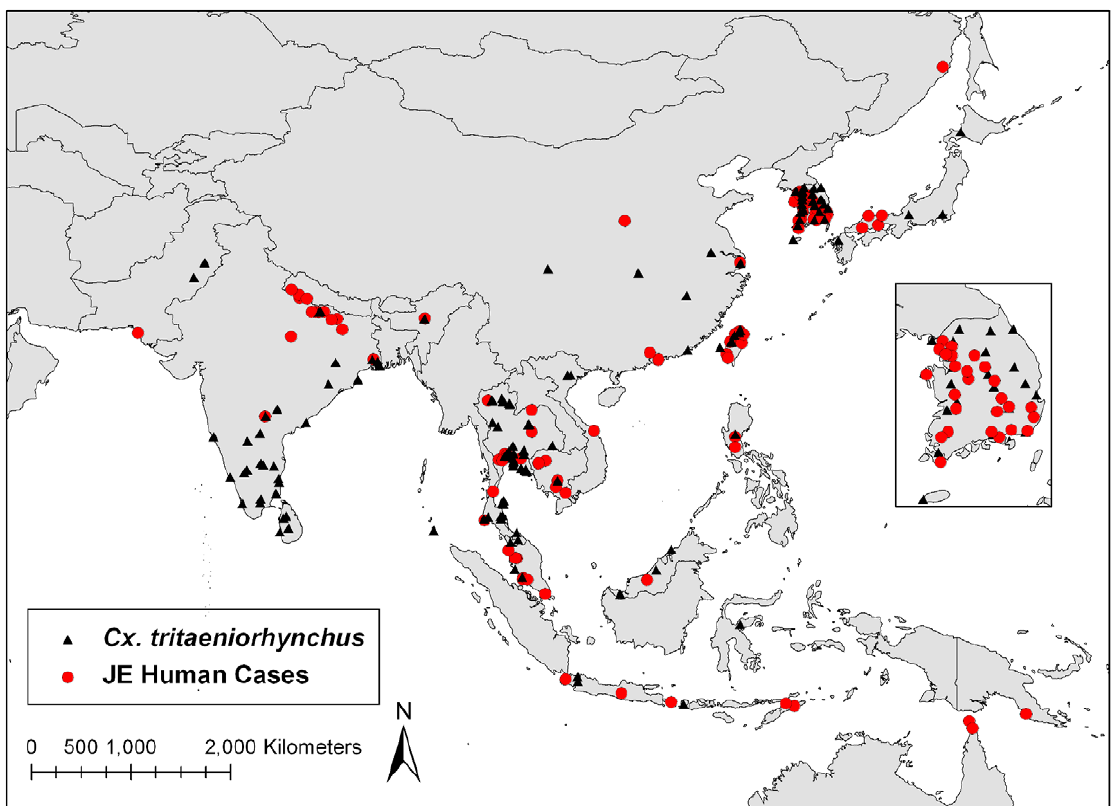
Figure 2. Distribution of known Cx.tritaeniorhynchus locations and documented human cases of JE within endemic region.